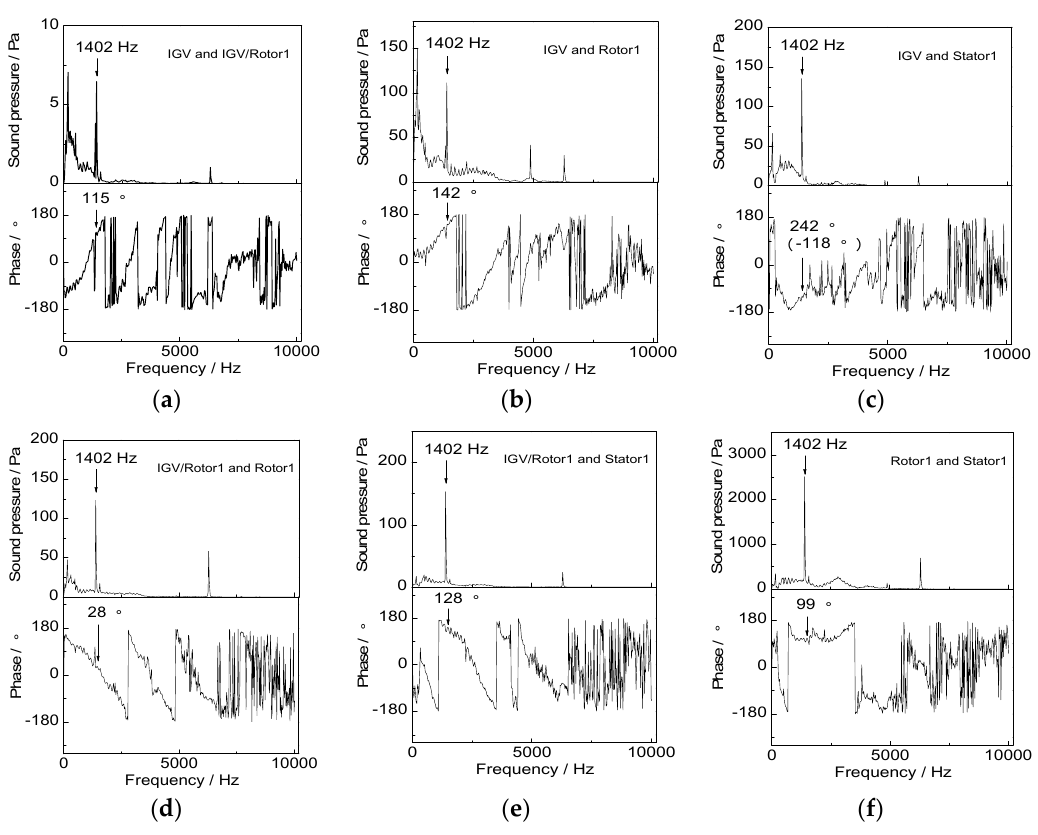
Figure 7. Cross-spectrum analysis about characteristic frequency noise. ( a ) The position of IGV and IGV/Rotor1. ( b ) The position of IGV and Rotor1. ( c ) The position of IGV and stator1. ( d ) The position of IGV/Rotor1 and Rotor1. ( e ) The position of IGV and Stator1. ( f ) The position of Rotor1 and Stator1. Table 2. Phase difference of characteristic frequency of noise signal at different measurement posi- tions.